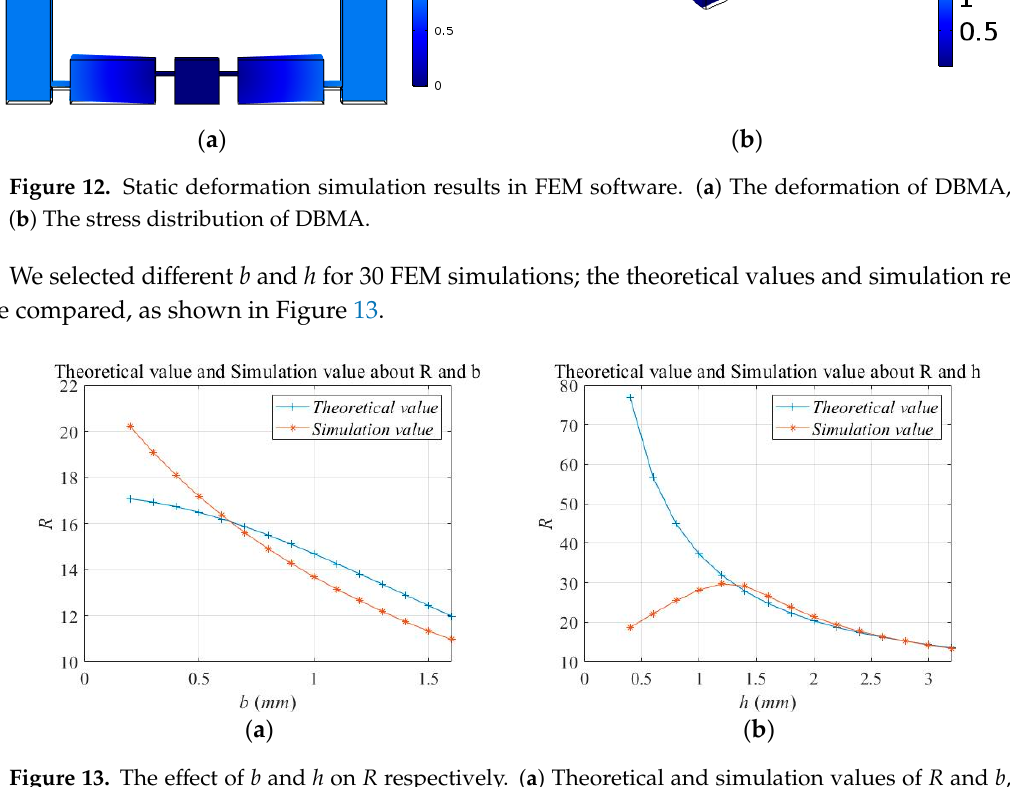
Figure 13. The effect of b and h on R respectively. ( a ) Theoretical and simulation values of R and b , ( b ) Theoretical and simulation values of R and h .